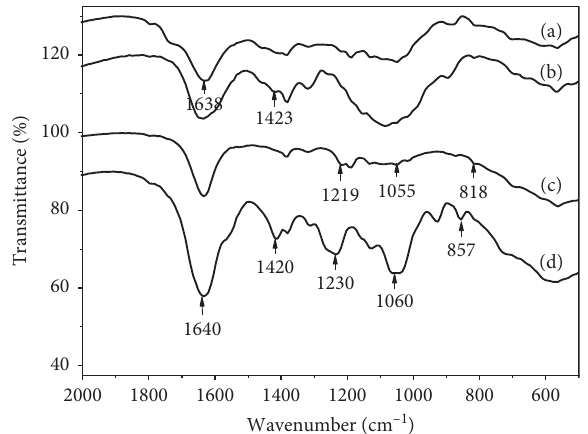
Figure 4: FTIR spectra of (a) chitosan; (b) SA; (c) CS; (d) SA/ chitosan nanoparticles loaded with